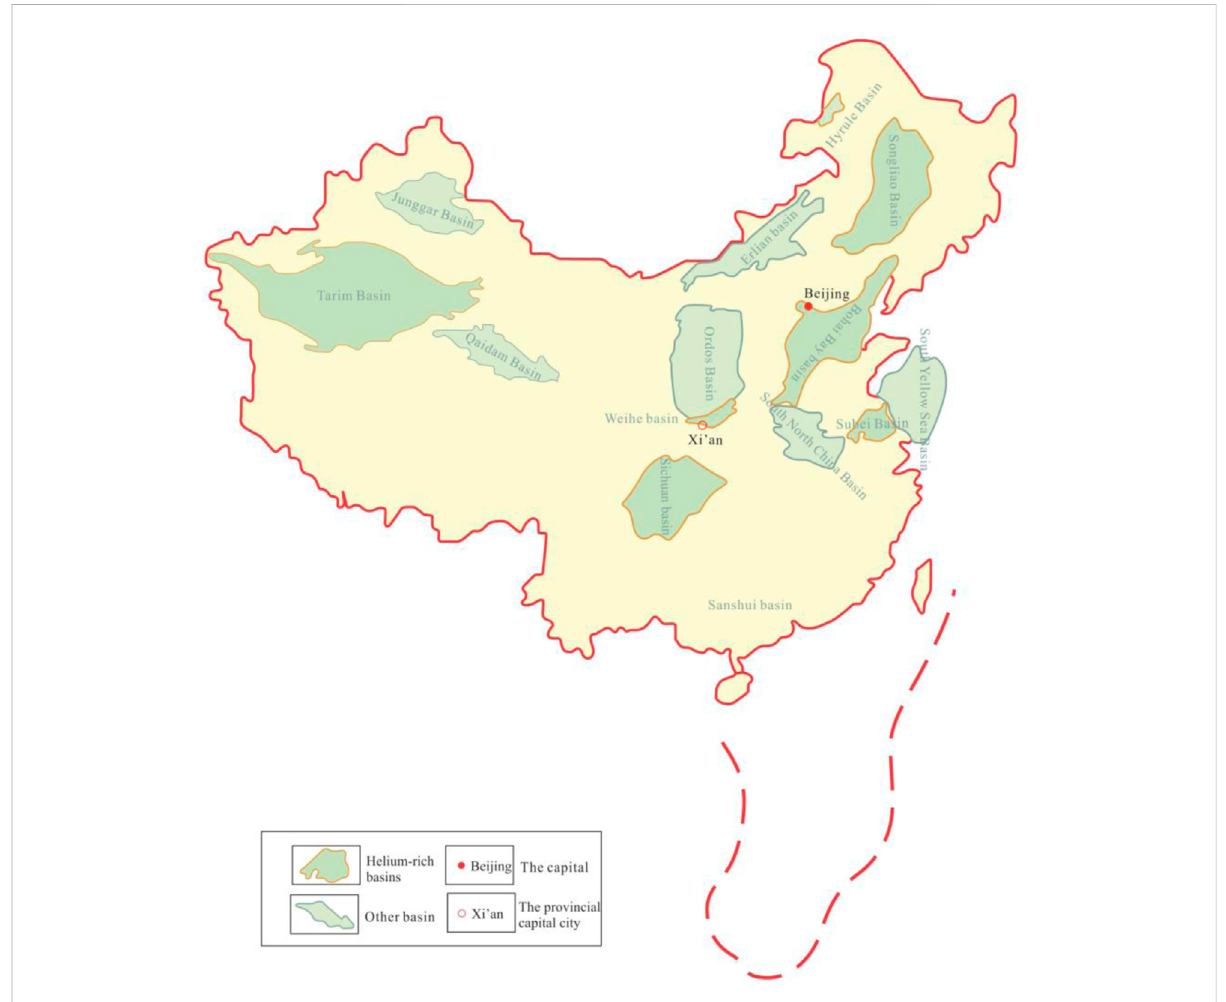
FIGURE 2 Distribution of helium-rich basins in China (Zhang et al.,